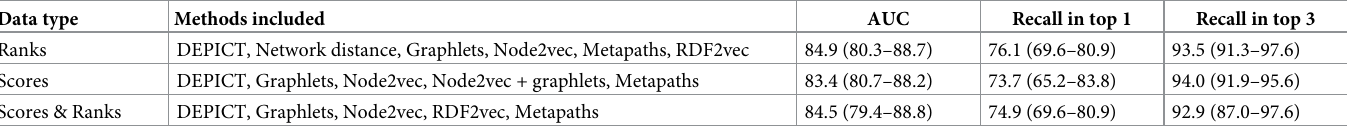
Table 4. Best performances of combinations of methods across the four reference sets. All values are percentages and indicate the average (minimum value–maximum value).